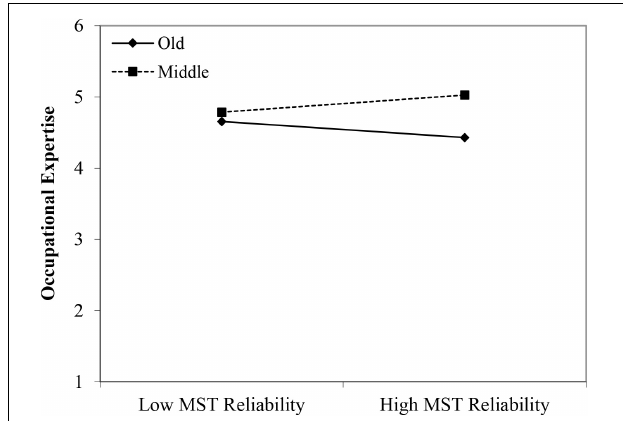
FIGURE 3 | Interaction between age-based (meta-)stereotyping of reliability and age groups: Predicting occupational expertise. Low = –1 SD , High = + 1 SD; ST = age-based (meta-)stereotyping old = older workers; middle = middle-aged workers.